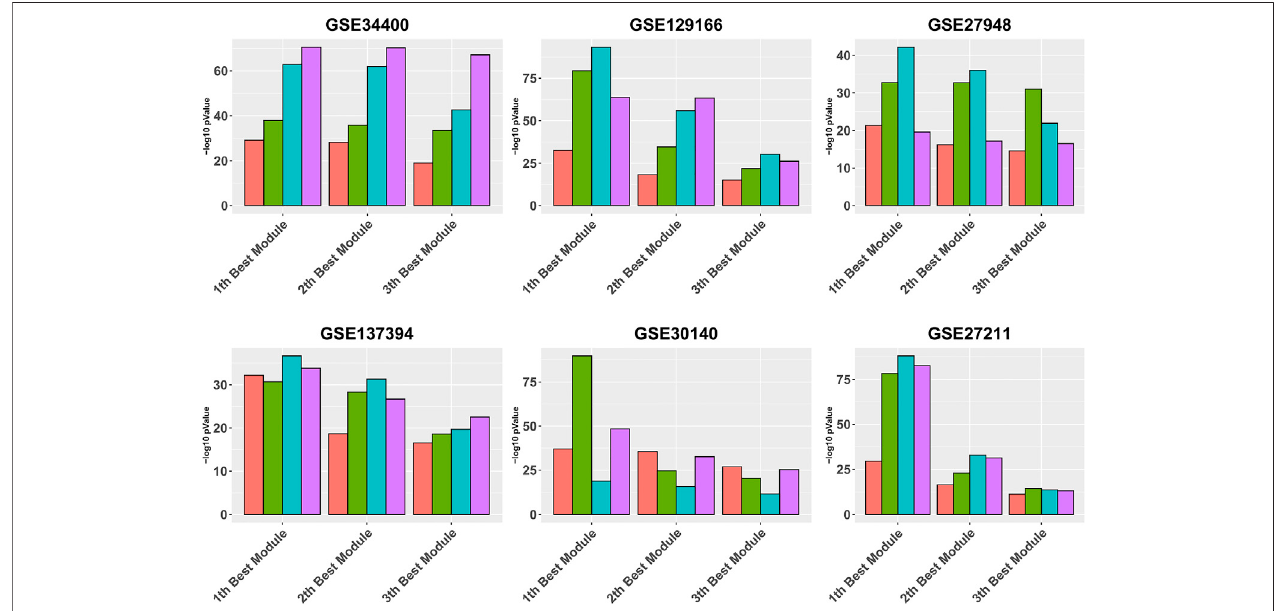
FIGURE 3 | Gene ontology enrichment analysis of 10 best modules produced by Alpha, Beta, Gamma, and WGCNA in six real data sets. The mean over the fi ve best GOenrichment p -values from the 10 top modules ofeach pipeline are compared. The x -axis and y -axis indicate the 10 best modules and the module performance